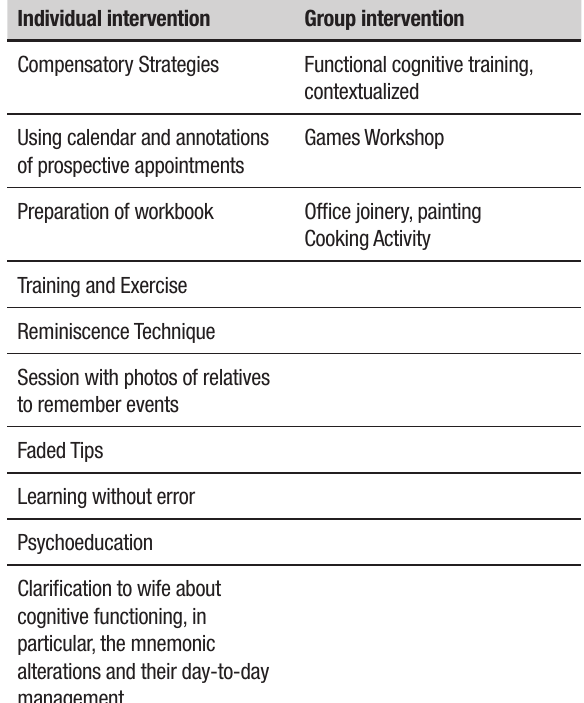
Table 1. Raw scores on cognitive function evaluation tests (attention, memory, visuo-construction and executive functions).